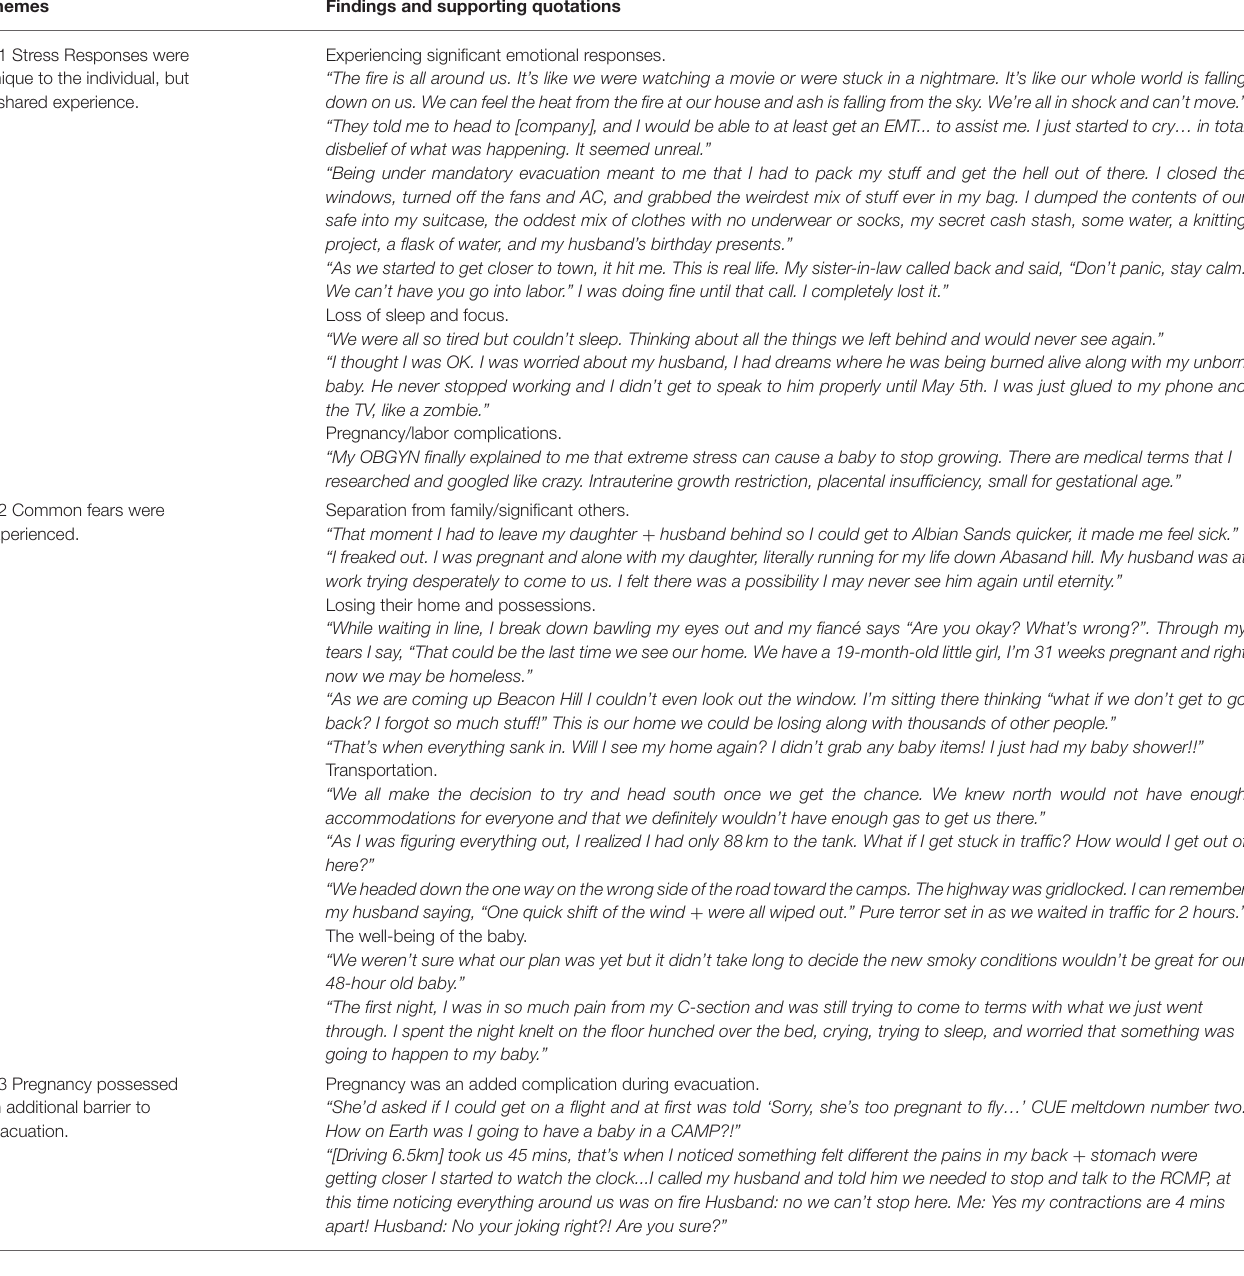
TABLE 1 | Theme 1: Experience of stress responses due to personal and external factors.